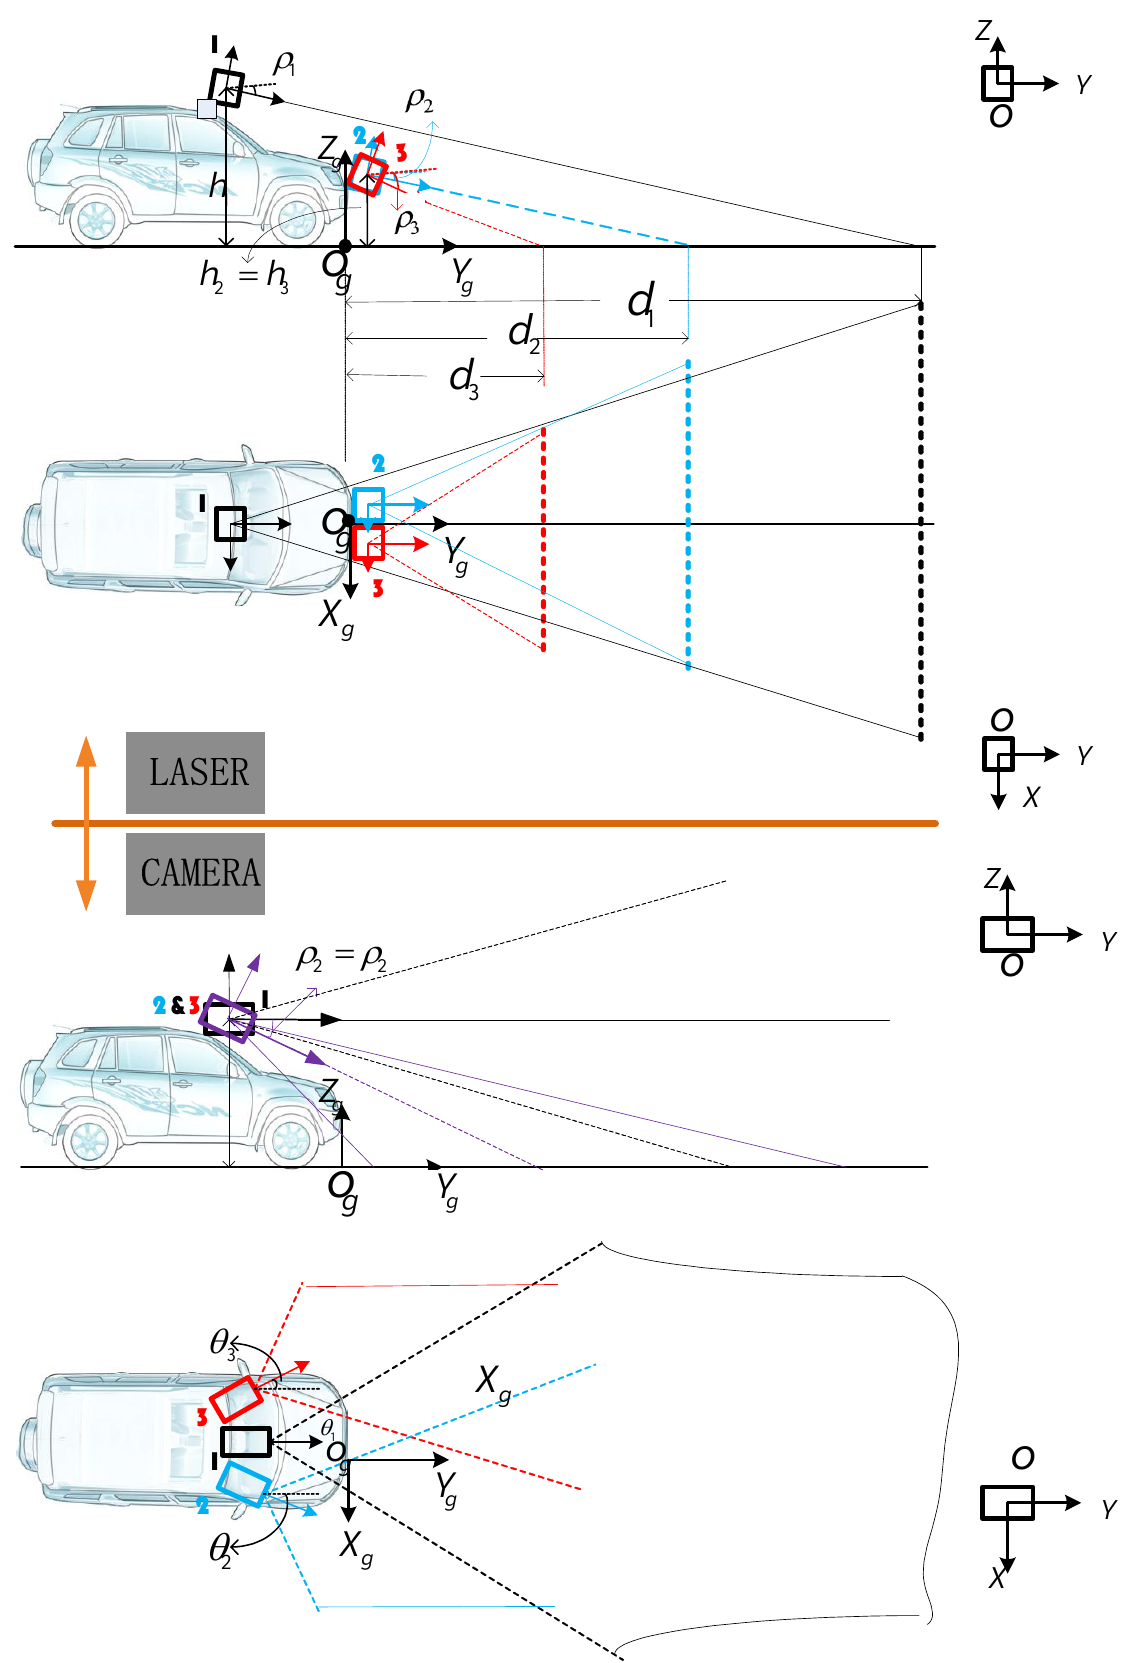
Figure 2. Lasers and cameras